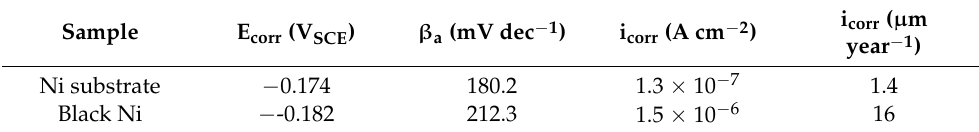
Figure 8. ( a ) Polarization curves measured after 2 h of immersion in 0.5 M NaCl; ( b ) Bode diagrams of the impedance measured after 4 h of immersion in 0.5 M NaCl. Spectra measured on the sample with black coating after 1 h, 120 h, and 144 h of immersion were identical to the spectrum after 4 h shown here. Table 4. Parameters obtained from the polarization curves in Figure